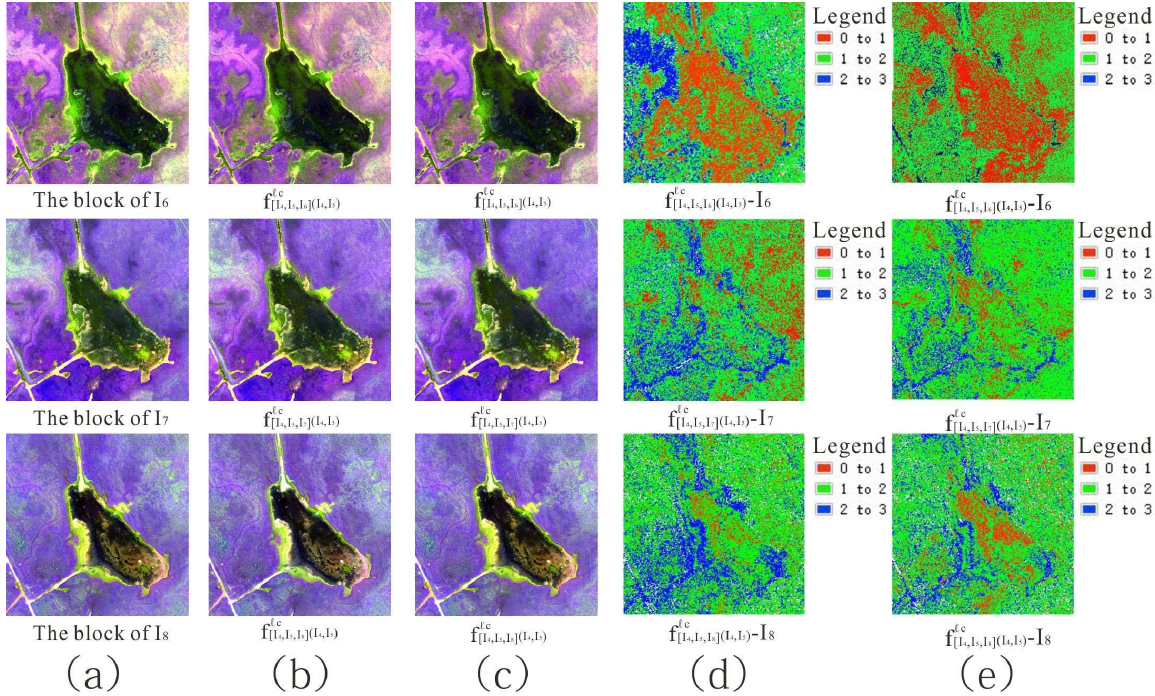
Figure 16. Visual effect and pixel error between block interpolated result and reference block using ( a ) initial image ( b , d ) average pooling and ( c , e ) maximum